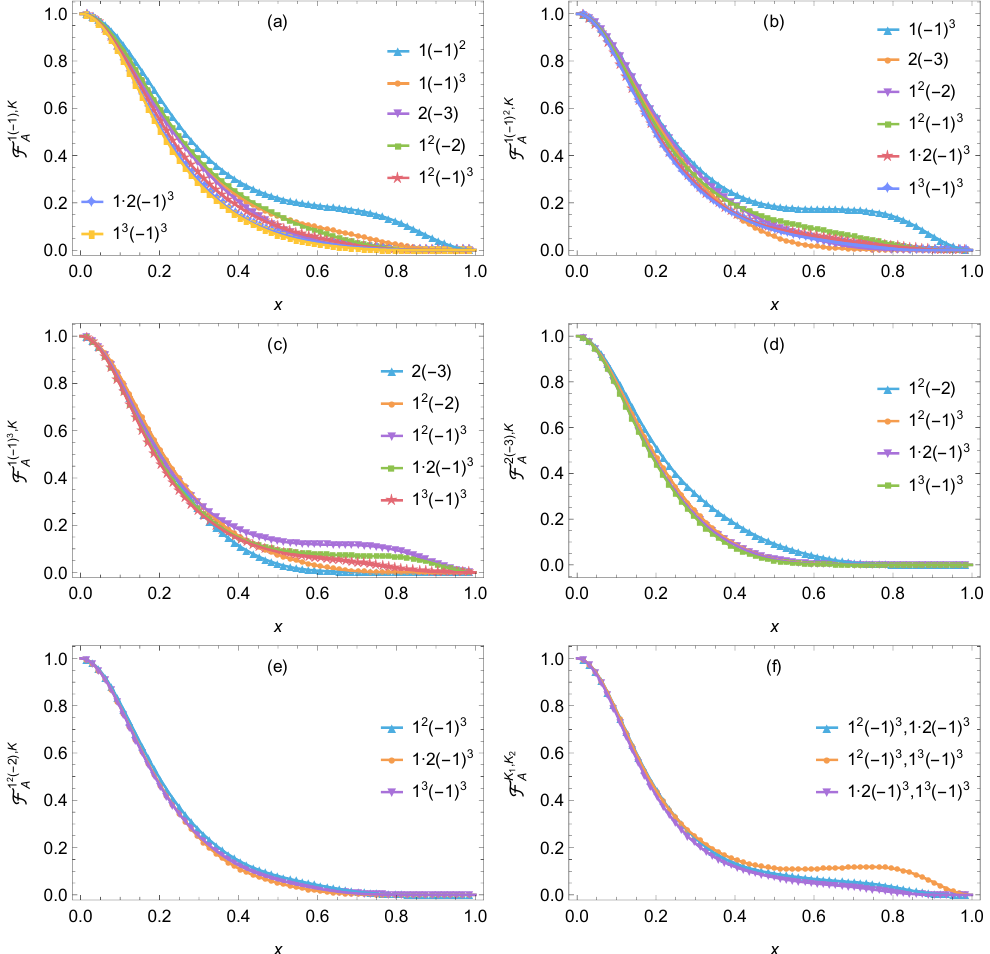
¯ X ¯ X in the 2D free massless non-compact bosonic theory (lines) 2 , X 3 4 A